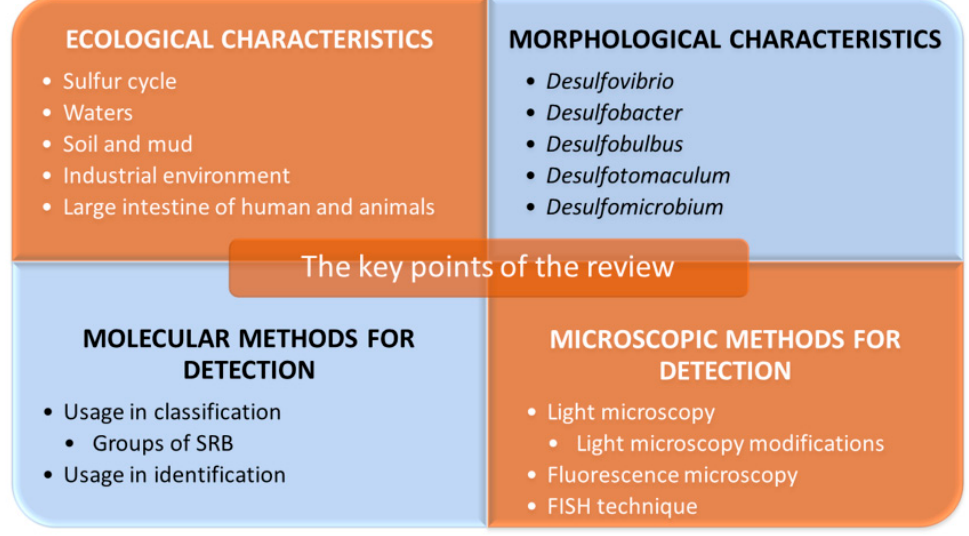
Figure 2. Main points of the review.